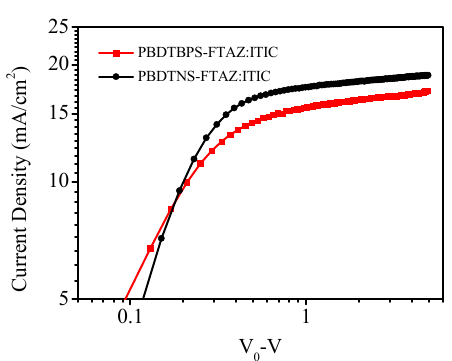
Figure 5. Photocurrent density versus effective voltage ( J ph - V eff ) characteristics.